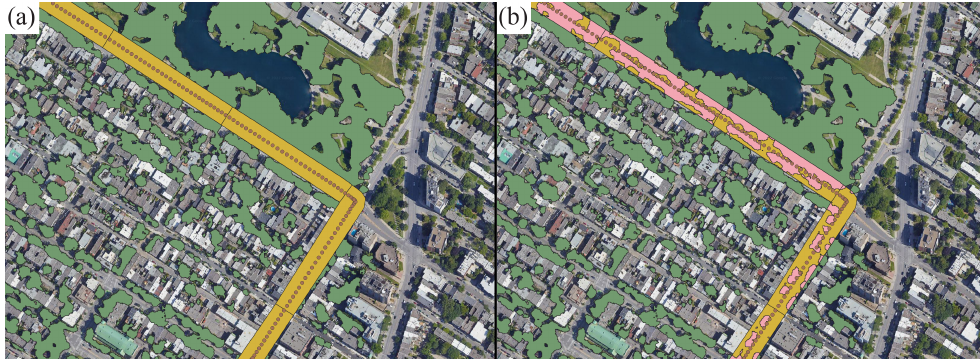
Figure 5. Example of road segments. ( a ) Road segment polygons. ( b ) Road segments with overlap- ping canopy.